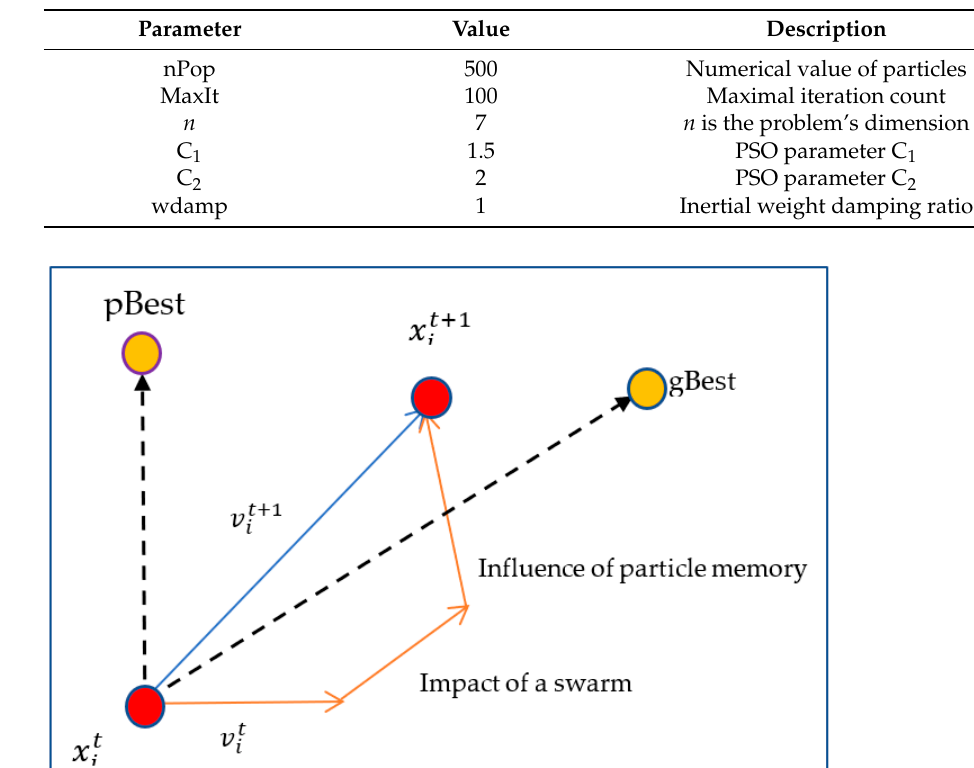
Figure 1. An individual particle’s movement in a particular step.